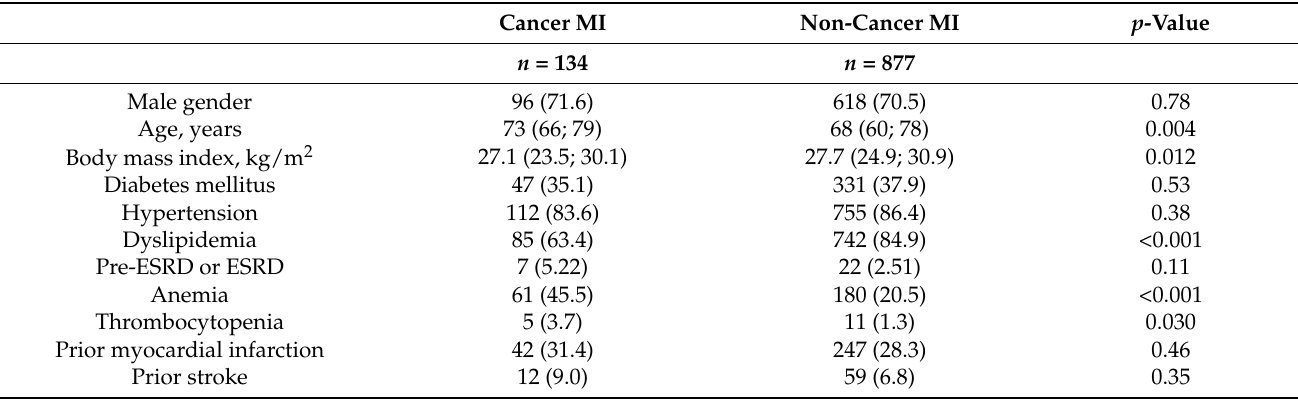
Table 1. Clinical characteristics of the studied